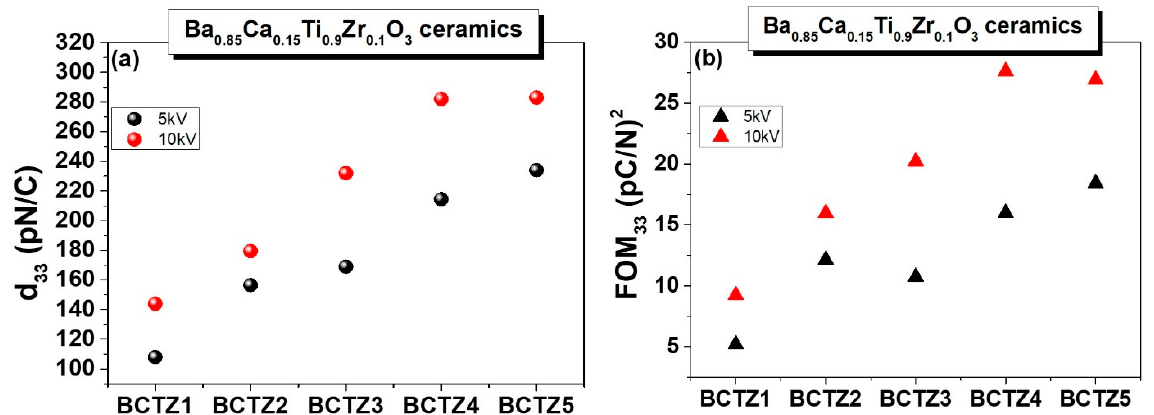
Figure 8. ( a ) Piezoelectric coefficient d 33 and ( b ) FOM 33 of BCZT ceramics determined for poling fields of 5 and 10